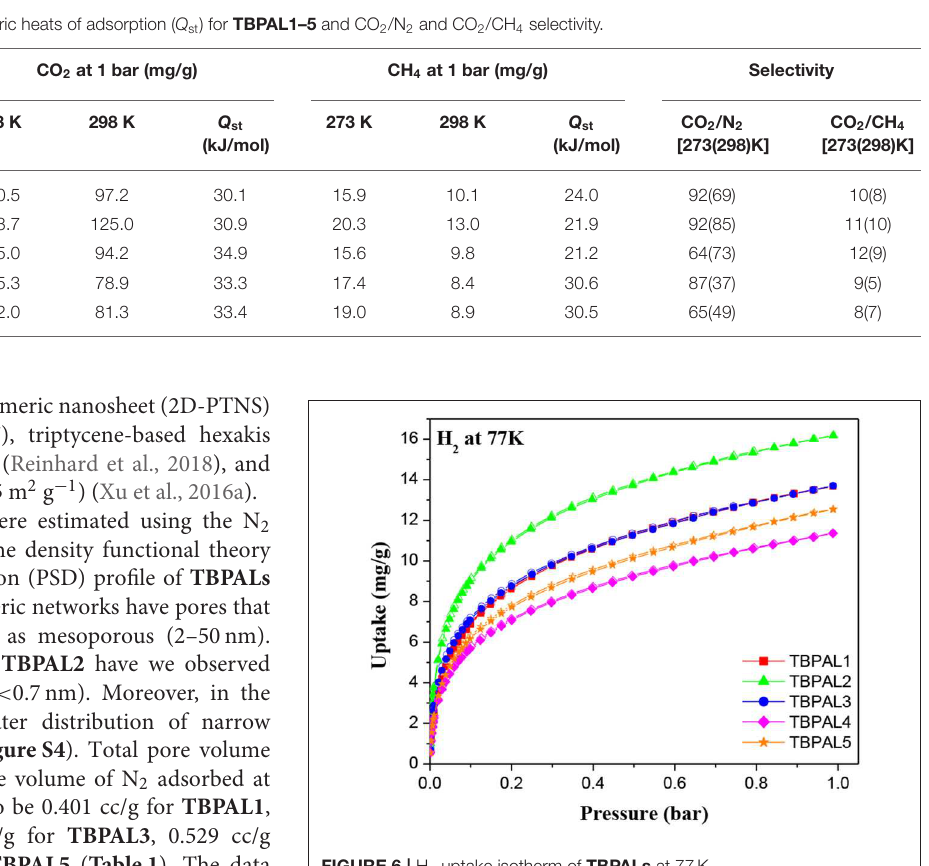
FIGURE 6 | H 2 uptake isotherm of TBPALs at